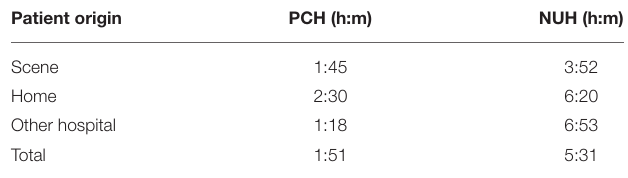
TABLE 4 | CT findings.